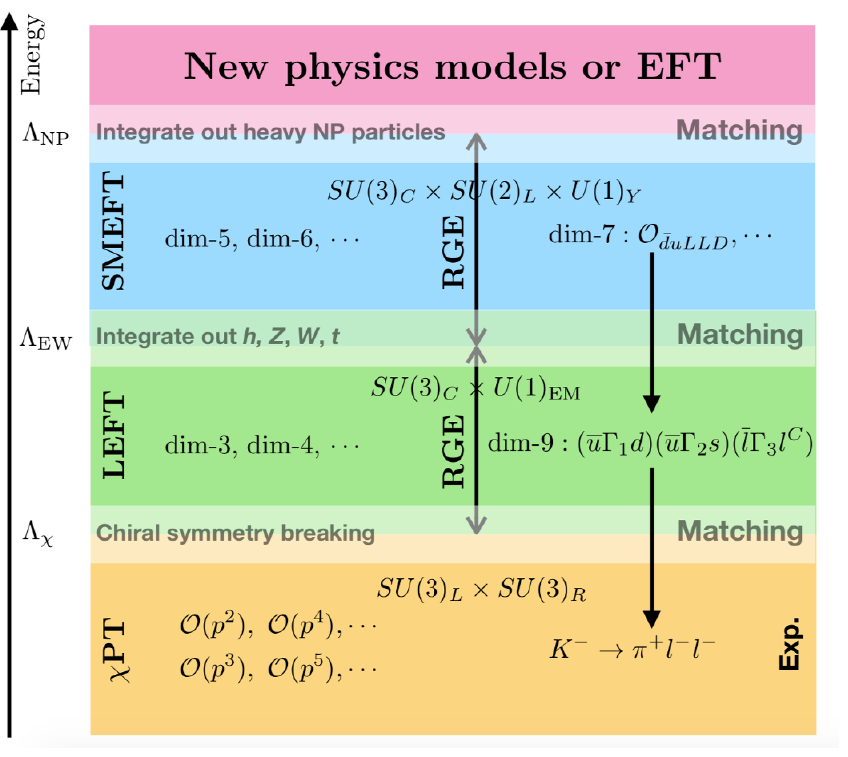
Figure 1 . Flow chart for a general EFT study is exempli(cid:12)ed by the decay K (cid:0) ! (cid:25) + l (cid:0) l (cid:0) from SMEFT, through LEFT, and to (cid:31) PT, with a sequence of matching calculation and renormalization group equations